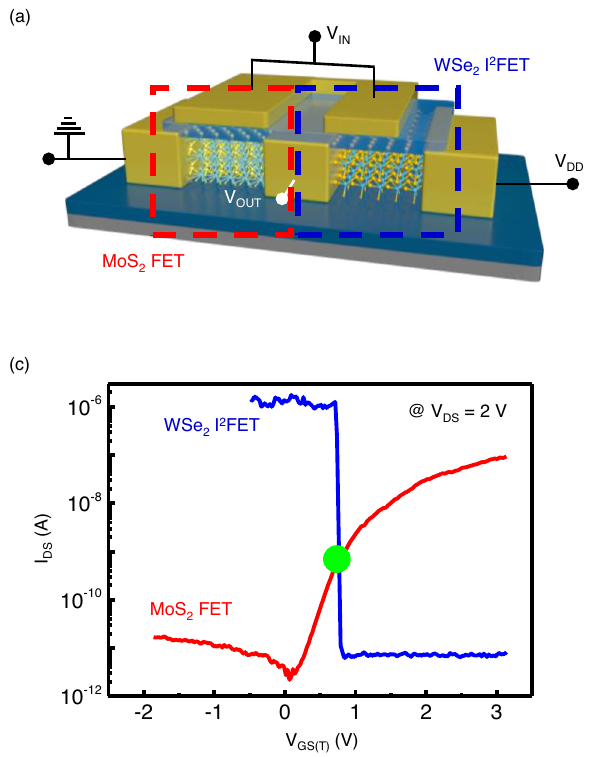
inverter. c I DS – V GS(T) curves of the WSe 2 I 2 FET and MoS 2 transistors (blue and red lines, respectively). d Inverter characteristics based on the WSe 2 I 2 FET in series with n-MoS 2